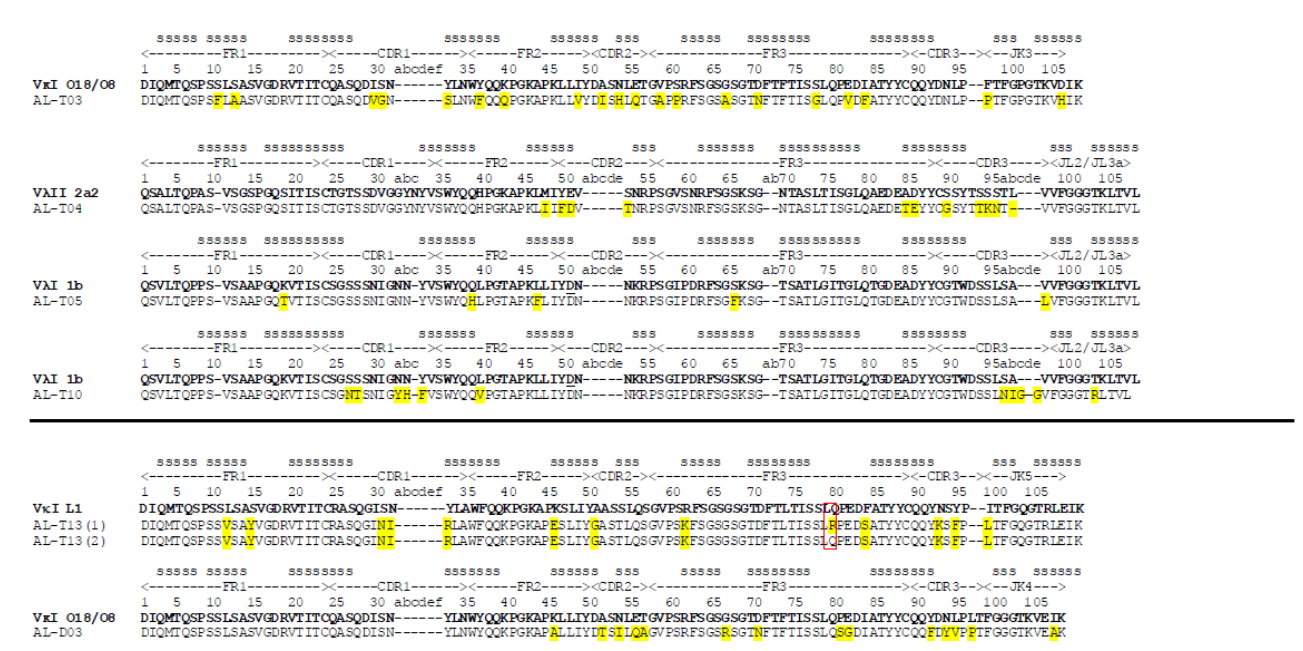
Figure 1. Protein sequence alignment corresponding to the variable domain of immunoglobulin light chains from light chain (AL) amyloidosis patients characterized in this study. The somatic mutations are shown as yellow highlights. The red box indicates the amino acid difference between AL-T13 (1) and AL-T13 (2). Each protein has been aligned with its corresponding germline donor sequence (using the Kabat nomenclature) and the secondary structure (s = β-strand) is shown from known crystallographic data as previously reported